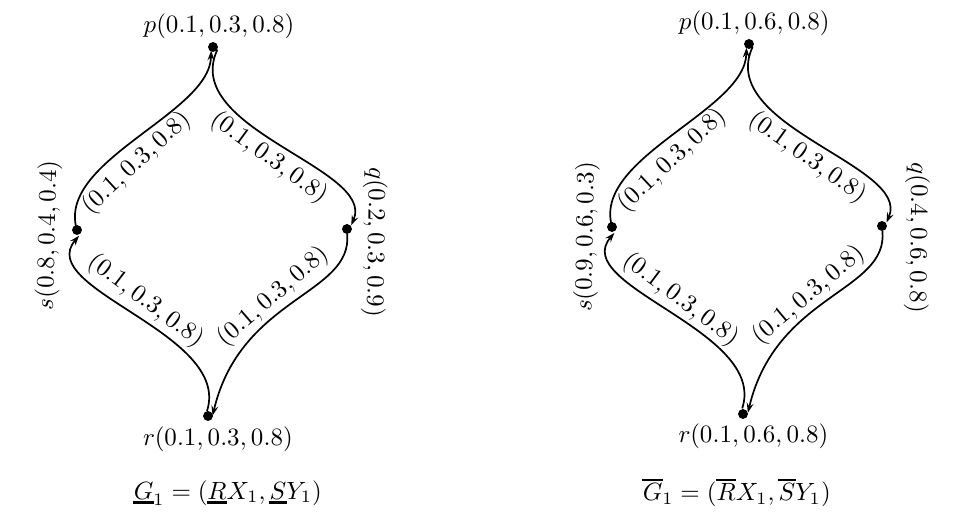
Figure 3: Regular Neutrosophic Rough Digraph G 1 = ( G